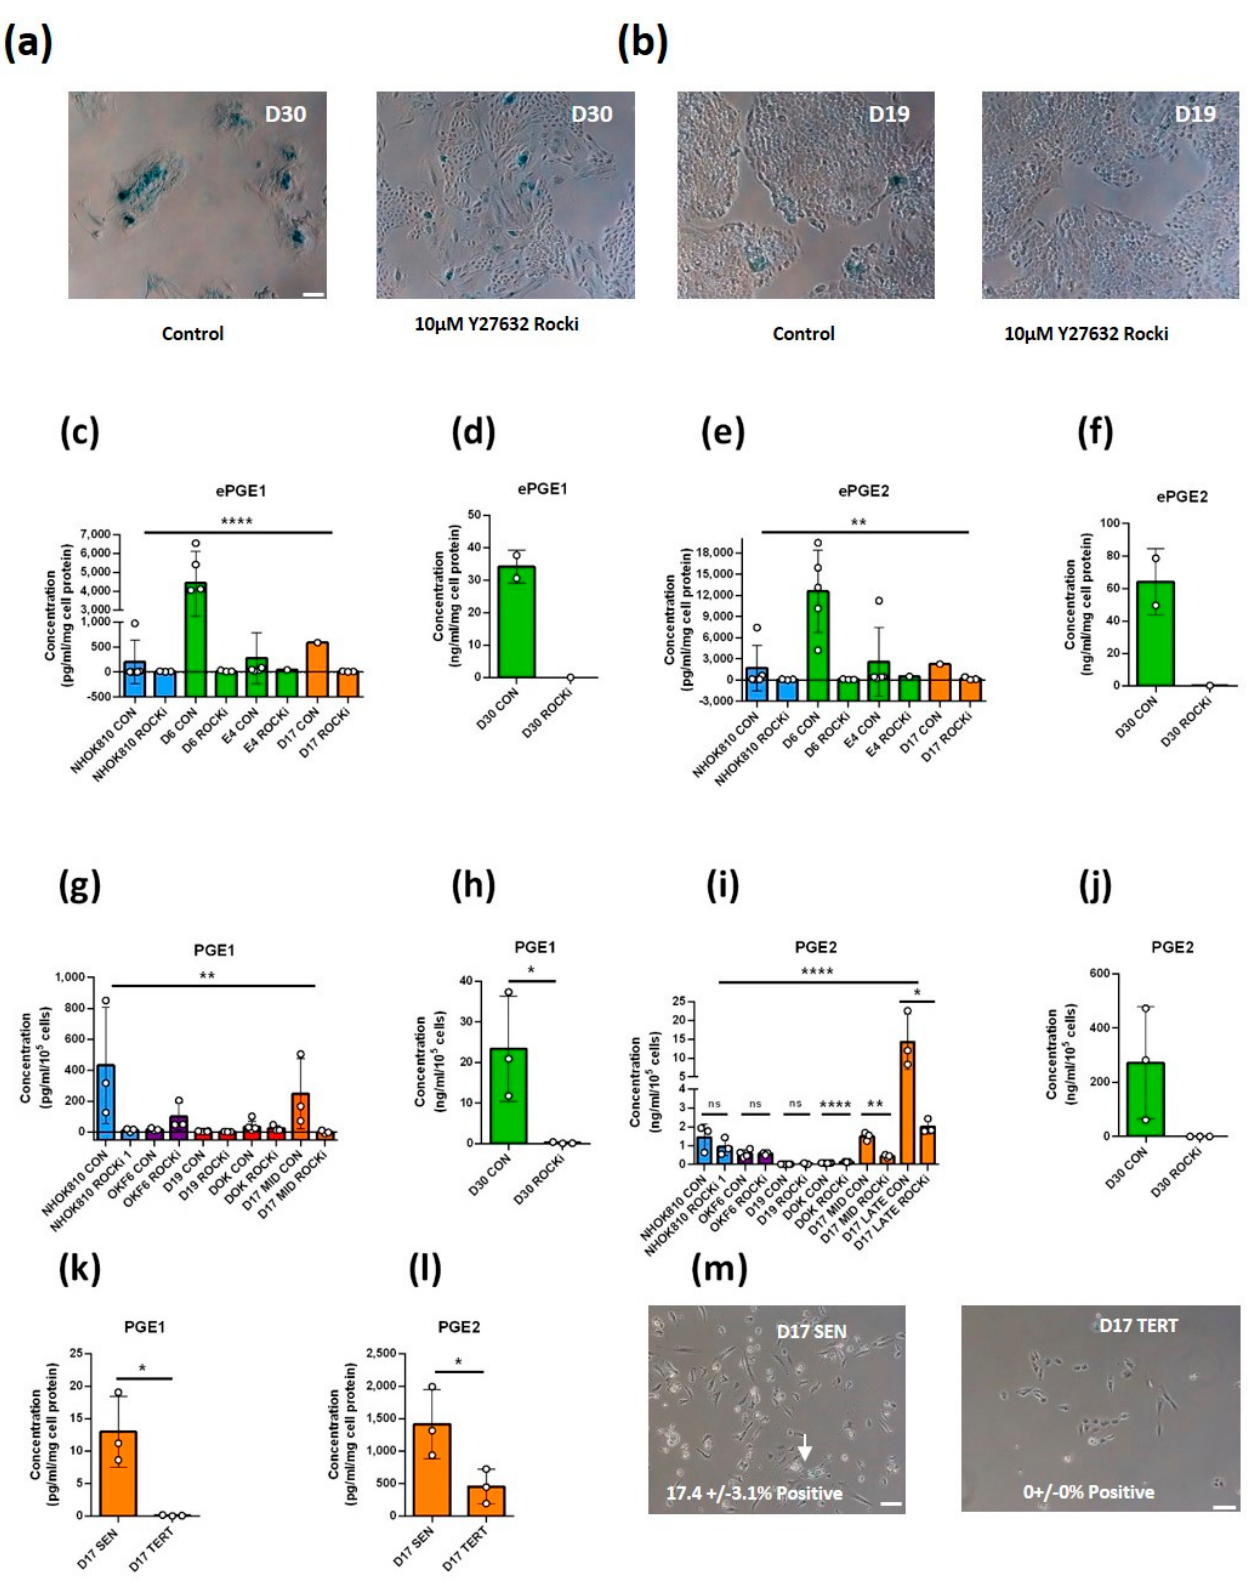
Figure 2. Ablation of the senescence program by ROCKi or ectopic TERT expression inhibits the expression of ePGEs. ( a ) SA- β staining of MPPOL line D30 +/ − ROCKi that showed reduced staining by ROCKi. Scale bar = 100 µ m. ( b ) SA- β staining of IPPOL line D19 as in ( a ) at the same magnification showing essentially no staining of the cells and unaffected by ROCKi. ( c – j ) The effect of ROCKi on